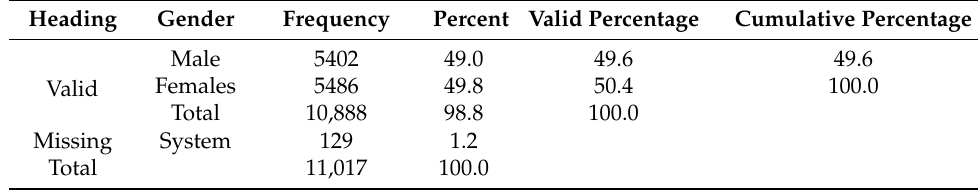
Table 1. Distribution of frequencies and percentages by